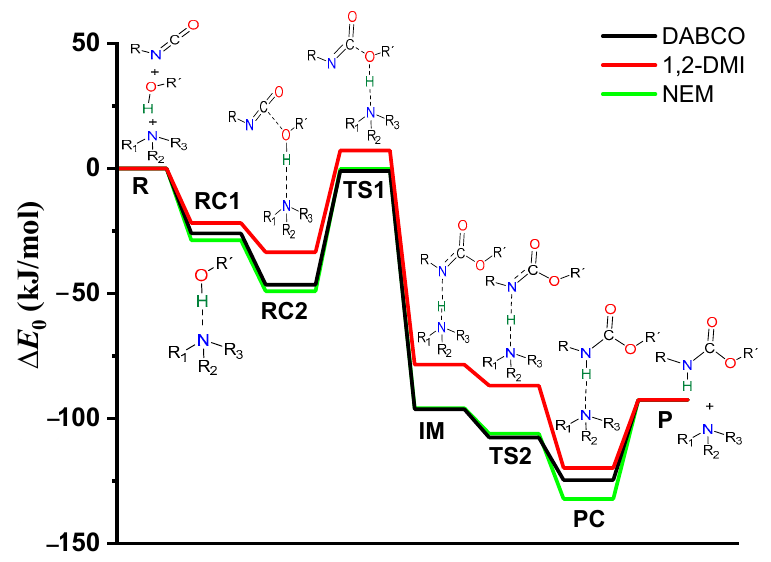
Figure 5. Energy profile (zero-point corrected, ∆ E 0 ) of the studied catalysed urethane formation reactions in the presence of 1,4-diazabicyclo[2.2.2]octane (DABCO), 1,2-dimethylimidazole (1,2-DMI), and N -ethylmorpholine (NEM) calculated at the G3PM2BHandHLYP level of theory in acetonitrile using the SMD implicit solvent model at 298.15 K and 1 atm.